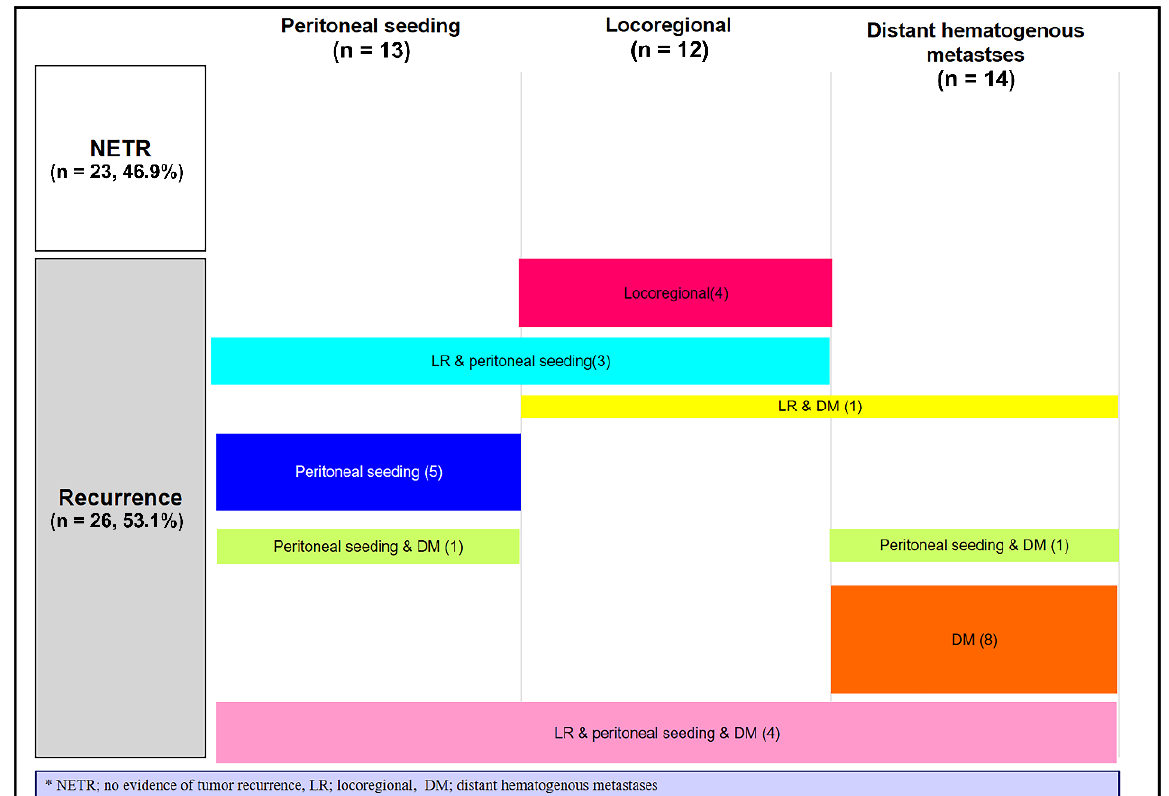
Figure 3. Failure patterns after stereotactic body proton beam therapy ( n = 49).